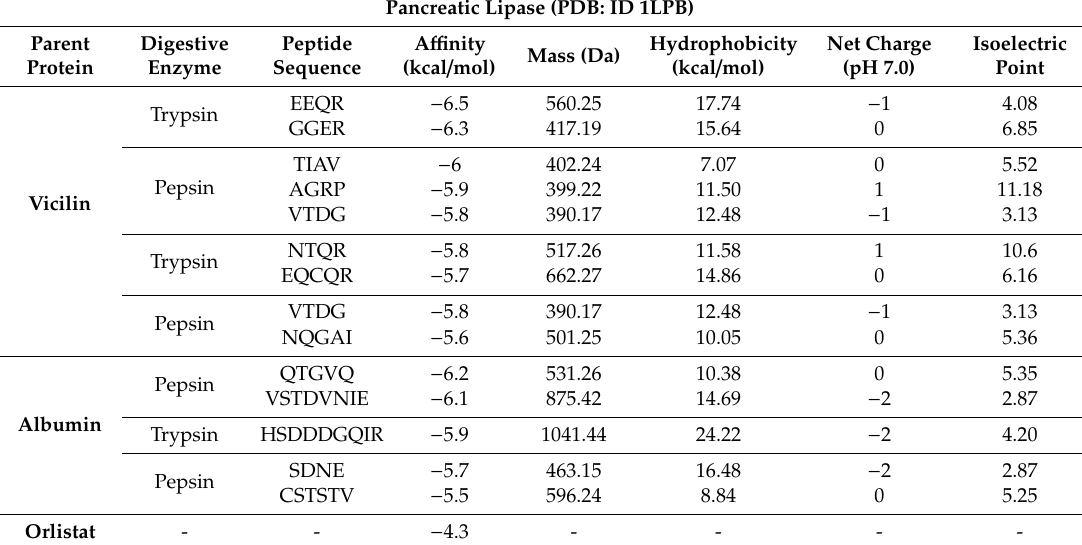
Table 3. Results obtained by molecular docking for cocoa peptides and orlistat on the enzyme pancreatic lipase (PL).